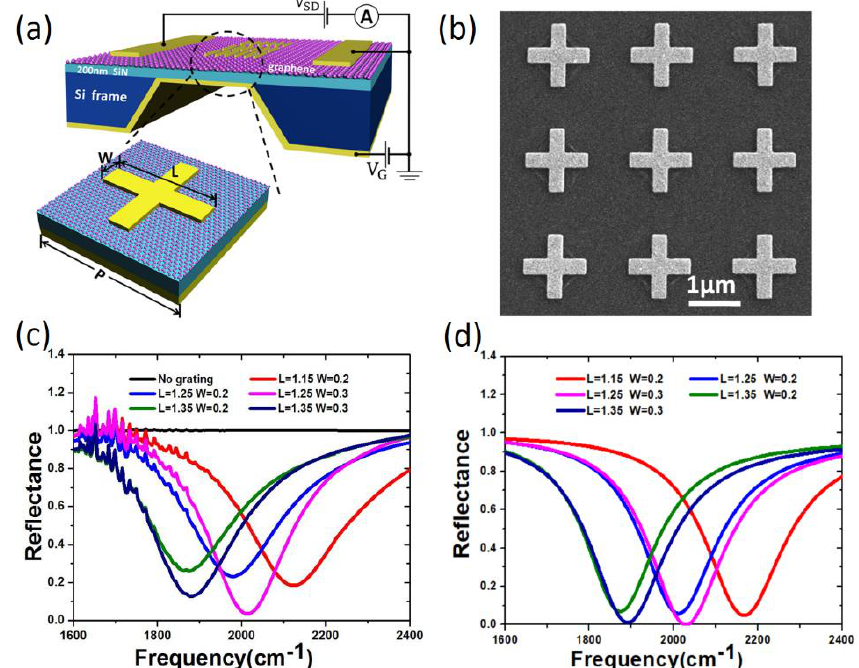
Figure 1. ( a ) The schematic of the graphene metamaterial perfect absorber and the unit cell of the metamaterial arrays. The tunable reflectance can be achieved by back-gating of graphene between the Si 3 N 4 membrane and the metasurface. ( b ) The SEM image of the metamaterial structure topping the absorber, with L = 1.25 µ m and W = 0.3 µ m. ( c ) Reflectance spectra for the absorbers in ( a ) with